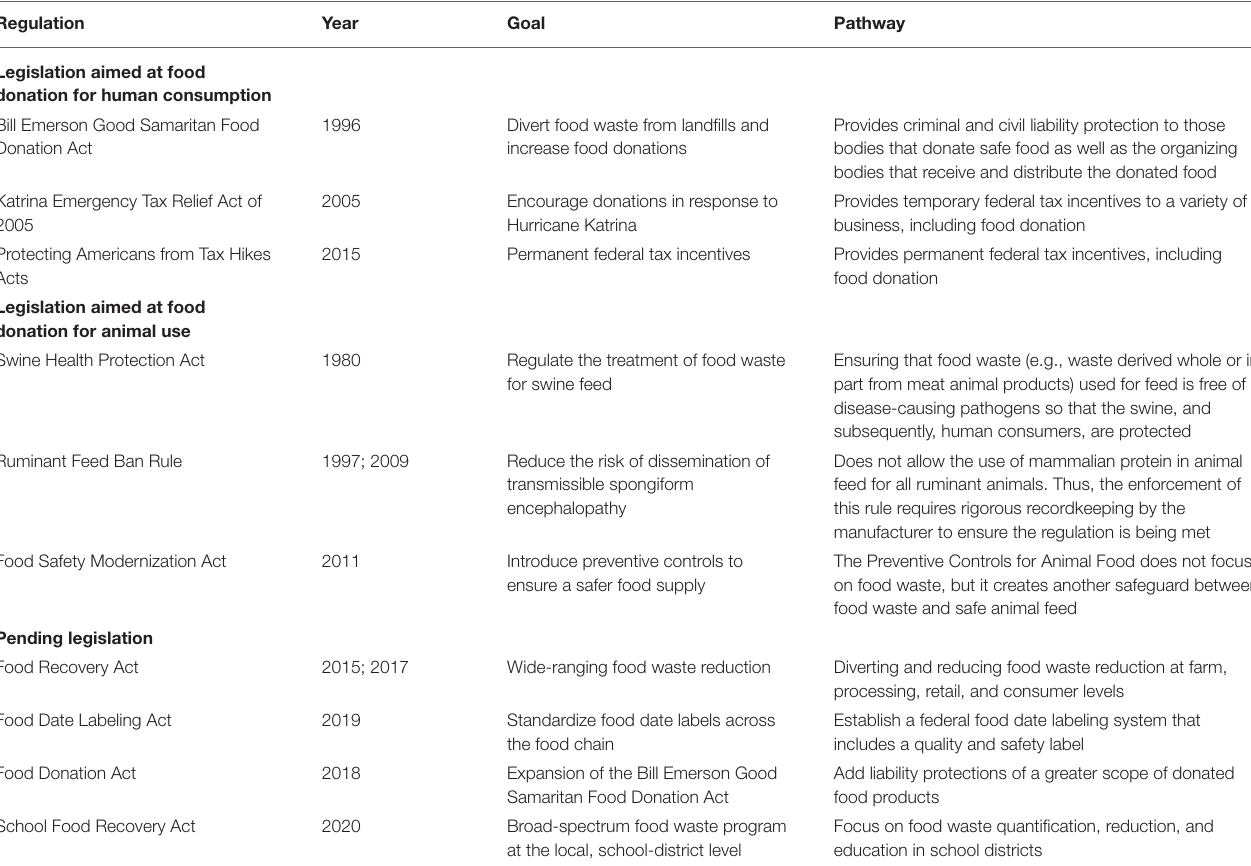
TABLE 2 | Food waste legislation in the United States.